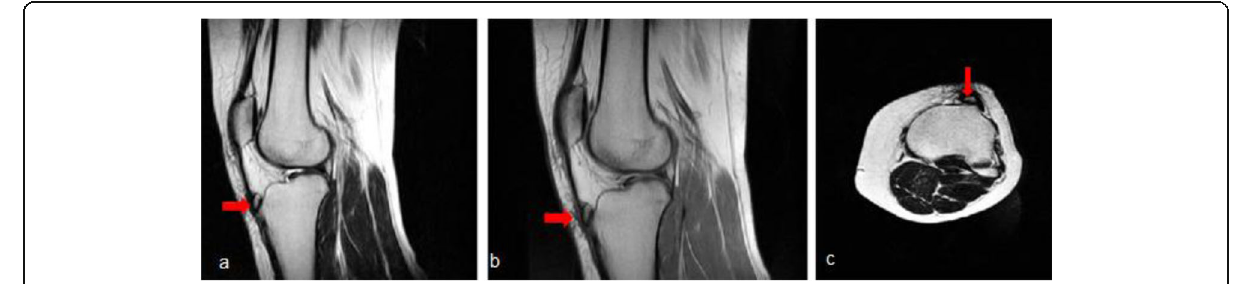
Fig. 13 a – c MRI images for old Osgood – Schlatter disease. a Sagittal T2, b sagittal PD, and c axial T2-weighted images demonstrated fragmentation of the tibial tuberosity (red arrows) with no surrounding soft tissue